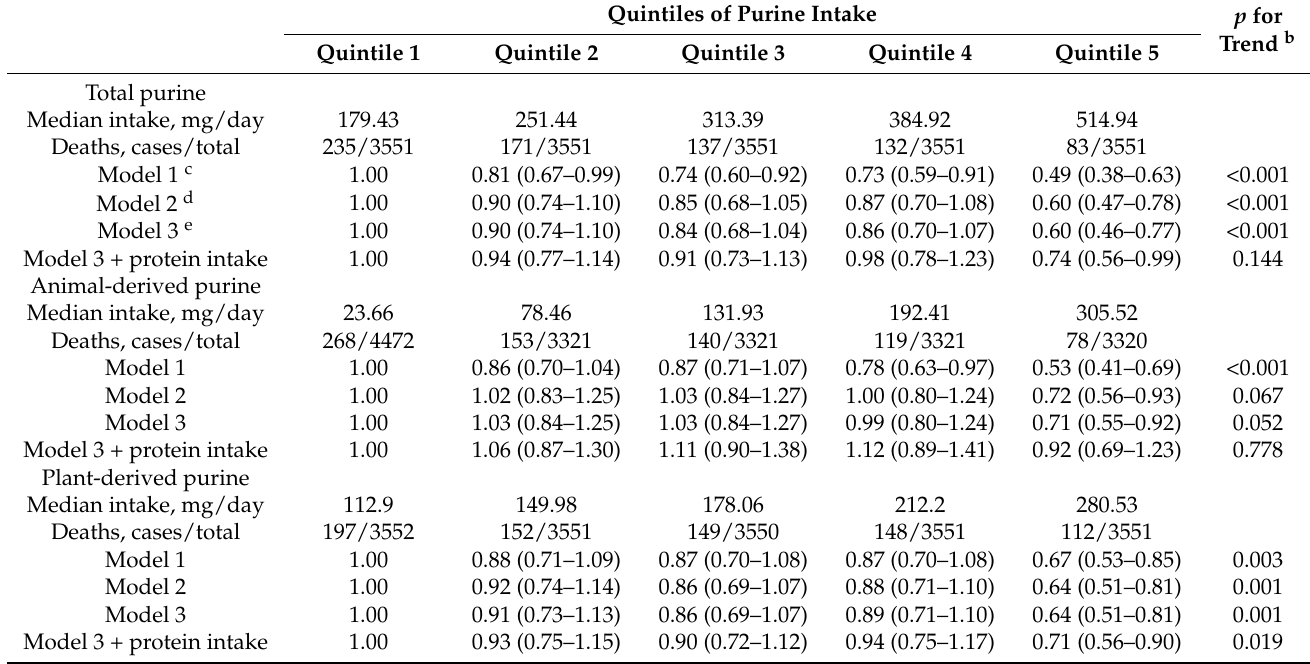
Table 2. HRs (95% CIs) of mortality according to the quintiles of purine intake a